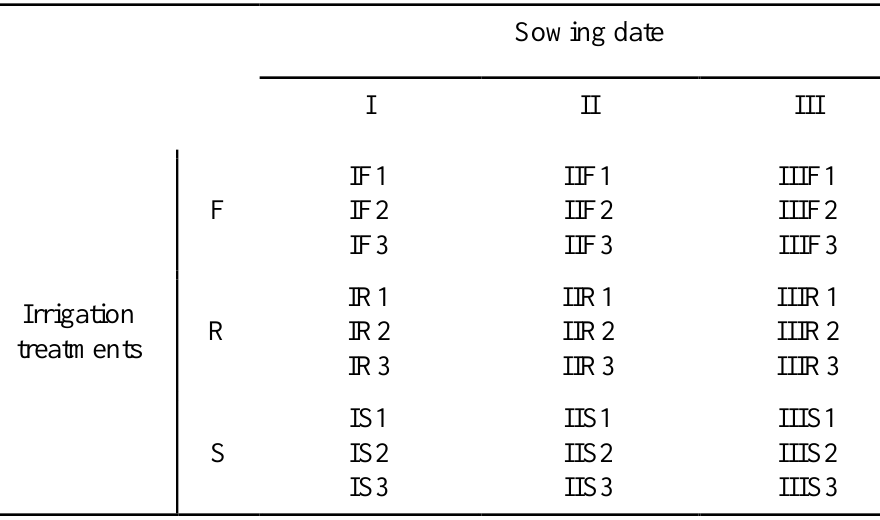
Figure 2. Design of the experiment.